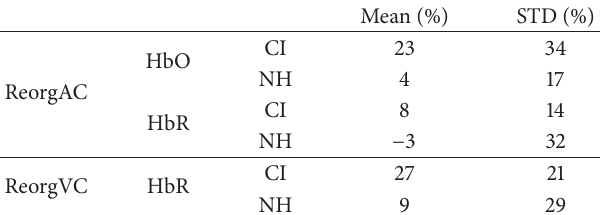
Table 2: Reorganizations in visual and auditory